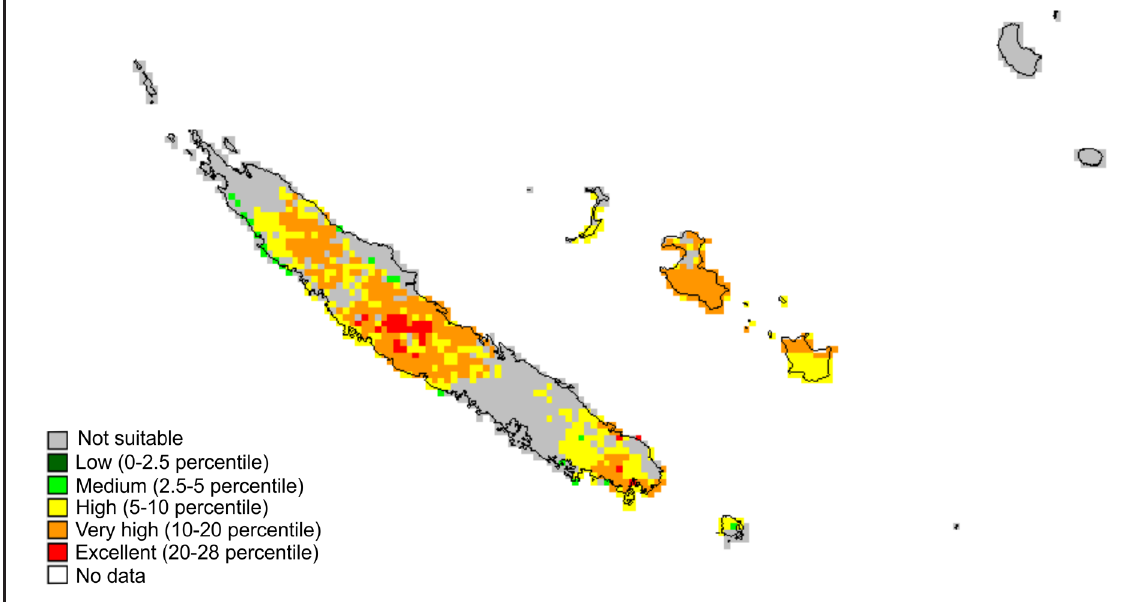
Fig. 11. Predicted distribution of Corambis Simon,